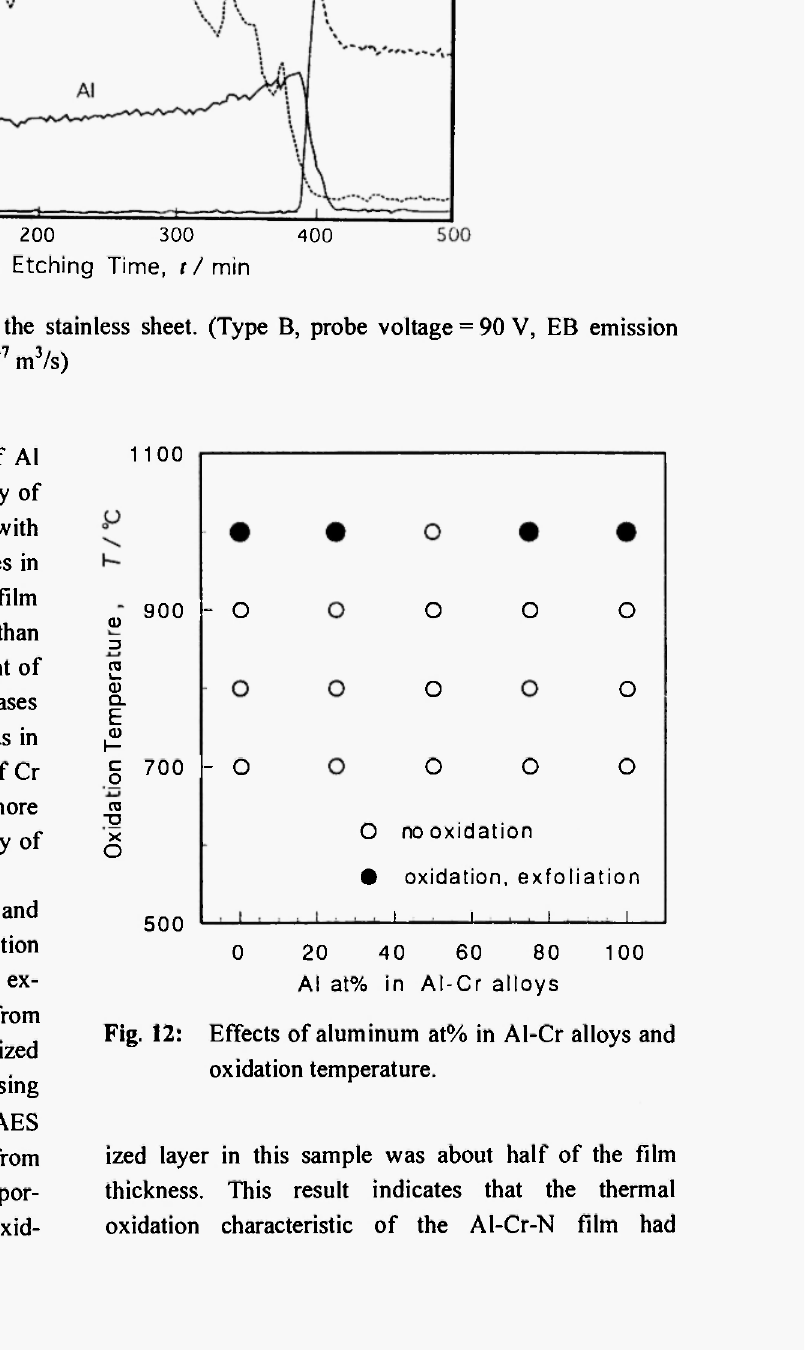
100 200 300 400 Ion Etching Time, r / m in Fig. 11: Auger depth profile of Al-Cr-N film on the stainless sheet. (Type B, probe voltage = 90 V, EB emission current = 0.17 A, N 2 flow rate = 3.33 χ 10" 7 m 3 /s)